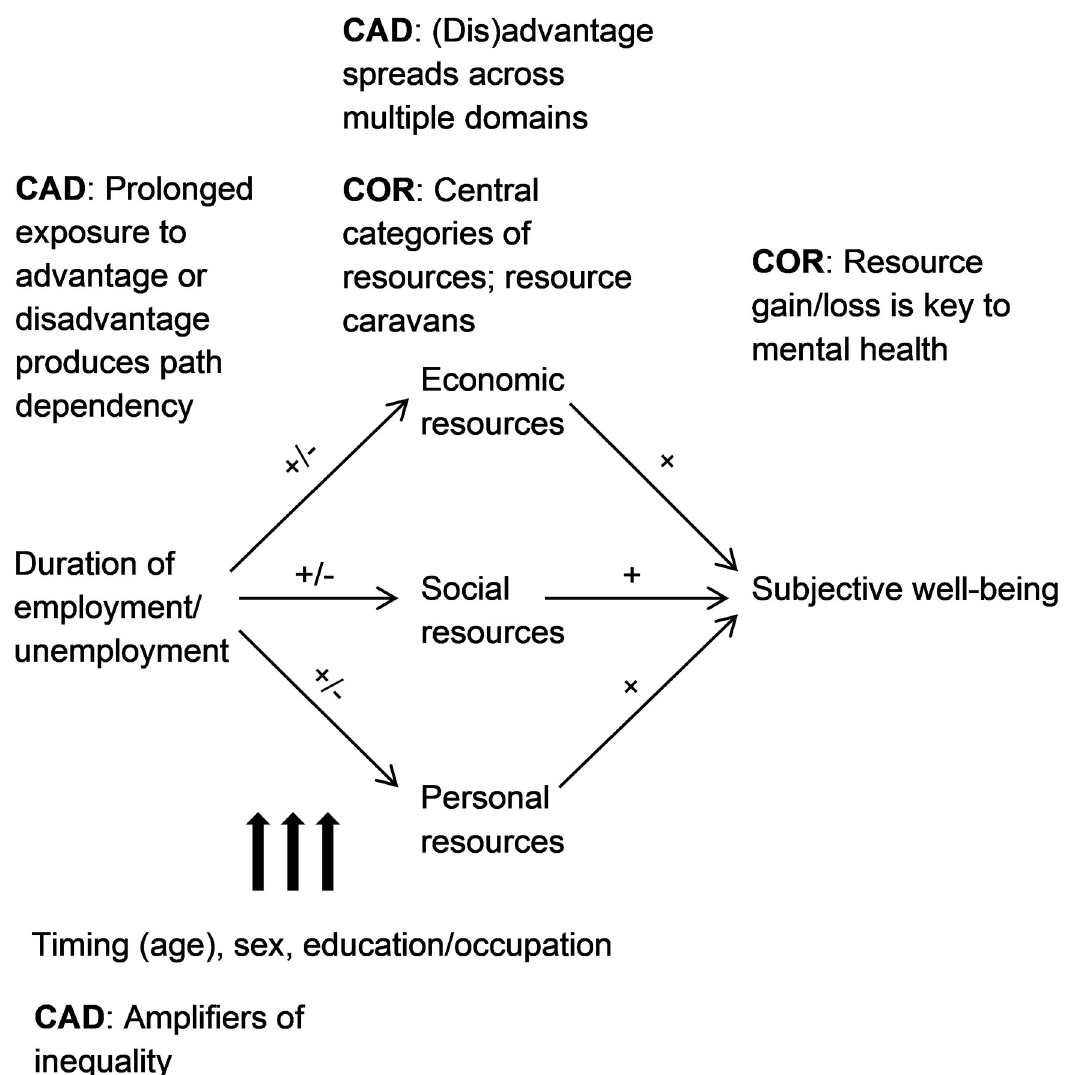
Fig 1. Conceptual model. CAD = cumulative (dis)advantage theory. COR = conservation of resources theory. The sign before slash refers to the effects of continuous employment; the sign after slash refers to the effects of continuous unemployment.